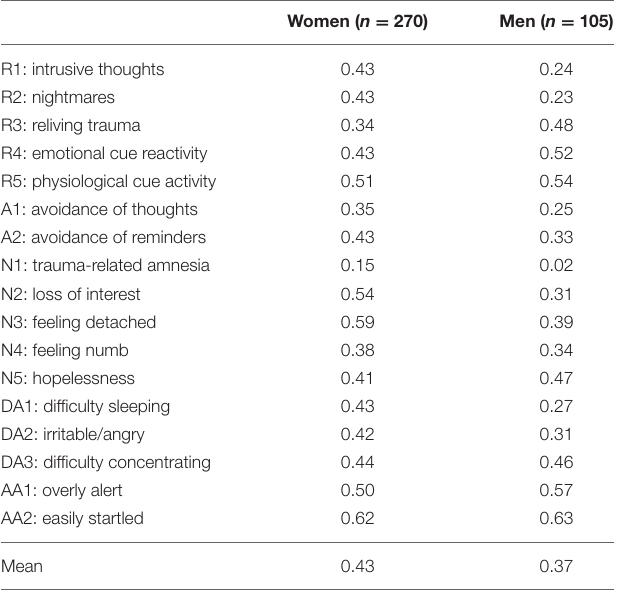
TABLE 5 | Predictability ( R 2 , the proportion of explained variance) of posttraumatic symptom scores in women and men with sum of PCL ≥ 30. Women ( n = 270) Men ( n =